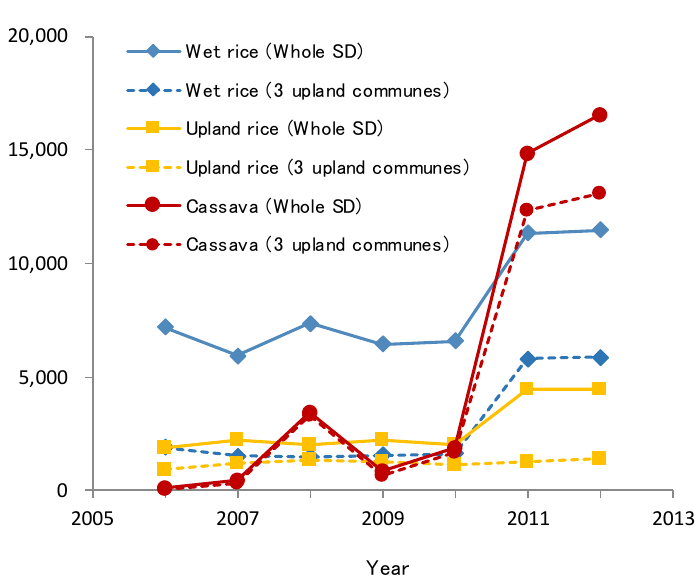
Figure 2. Changes in the cultivated area of three major crops in the study site